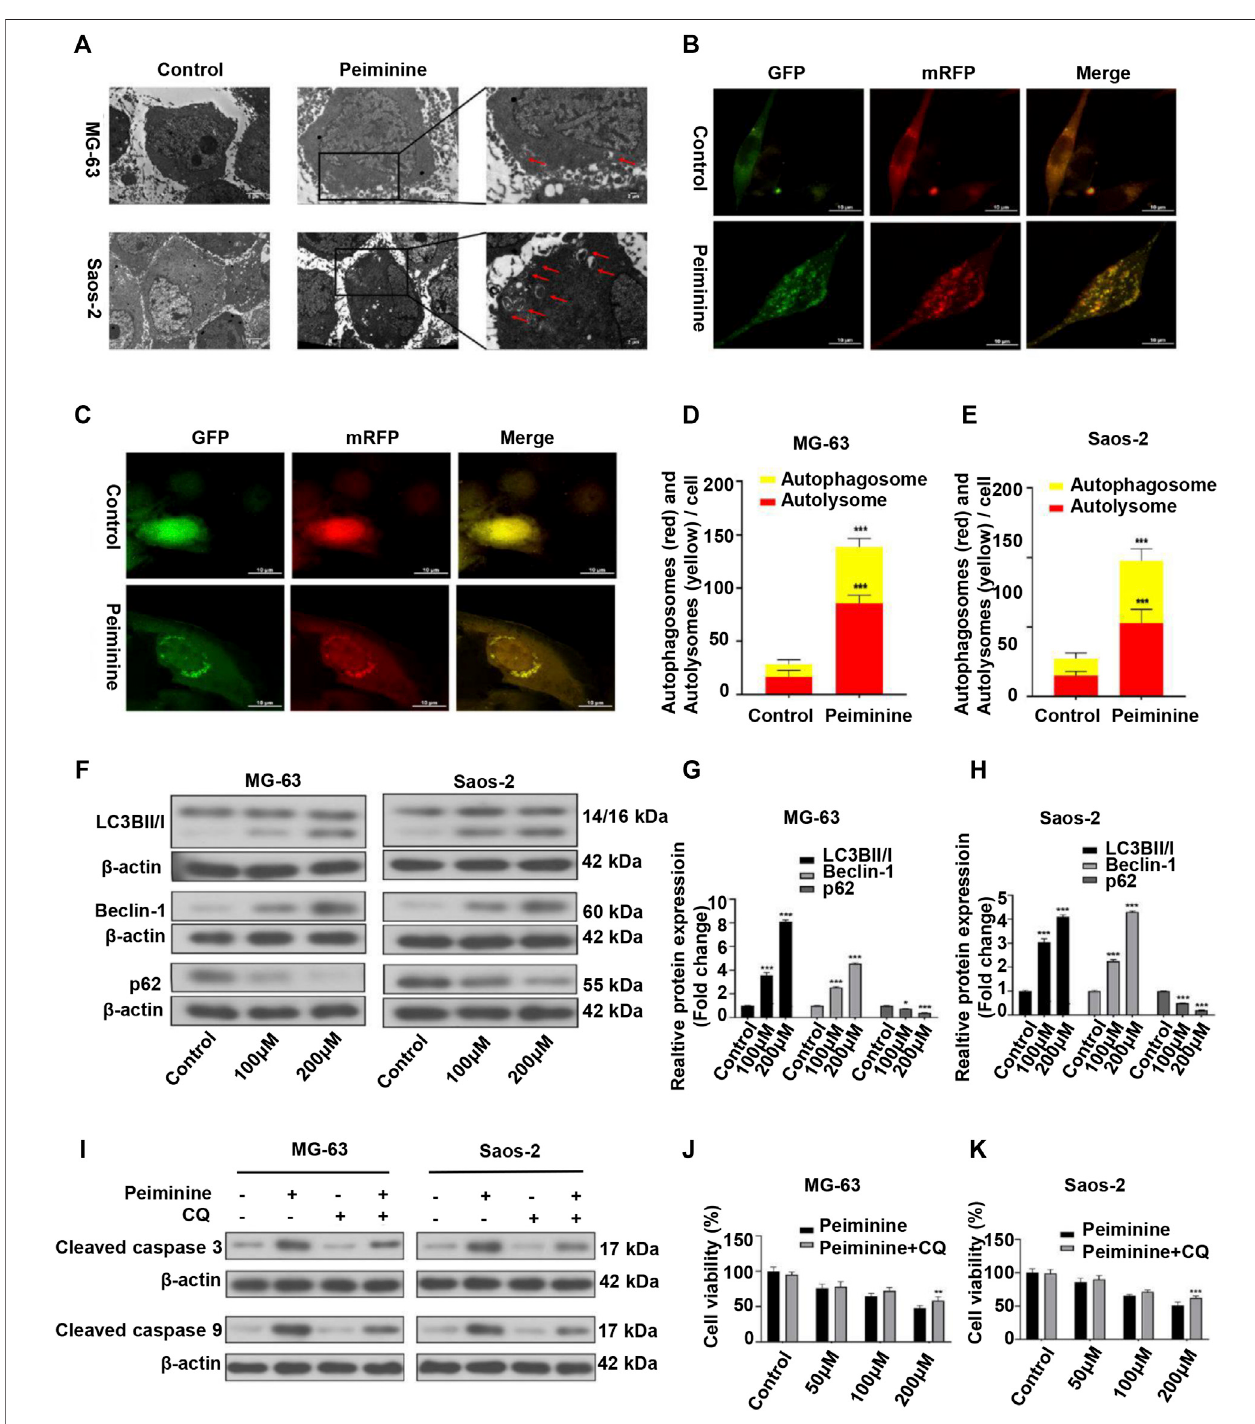
FIGURE 4 | Peiminine induced autophagy in osteosarcoma (OS) cells. (A) Transmission electron micrographs showing autophagosome formation. Autophagosomesareindicatedbyarrows.Control,Lowerscalebar (cid:2) 5 μ m,Upperscalebar (cid:2) 2 μ m. (B,C) Peiminineinducedautophagic fl ux.Scalebar (cid:2) 10 μ m. (D,E) Quantitativeanalysisofautophagic fl uxinOScells. (F – H) OScellsweretreatedwithpeiminineatvariousconcentrationsfor48 h.Theexpressionlevelsoftheautophagy- relatedproteinsLC3BII/I,beclin-1,andp62weremeasuredbywesternblot( n (cid:2) 3). β -actinservedascontrol. (J,K) OScellswerepretreated withchloroquine(CQ, 20 μ M) for 2 h and then treated with peiminine for 48 h. Cell viability was assessed by cell counting kit-8 (CCK-8) assay. (I) The levels of apoptosis-related proteins were measured by western blot after peiminine treatment in the presence or absence of CQ. * p < 0.05, ** p < 0.01, *** p < 0.001.